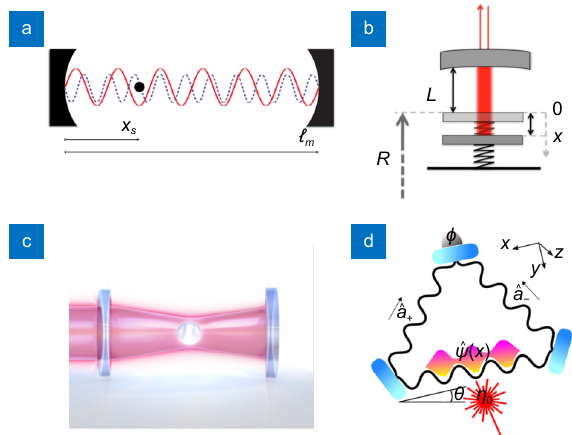
Fig. 29 | Schematics of different setups for light-matter interac- tion based detection. ( a ) A cavity with a microdisk trapped by a light field, which is cooled for a readout by a second light field 166 . ( b ) An optomechanical cavity with an injected light field and an elastic mechanical mirror 164 . ( c ) An optomechanical system with a trapped and laser-cooled nanodiamond 165 . ( d ) A ring cavity comprising three tilted mirrors 167 . Figure reproduced with permission from: (a) ref. 166 and (b) ref. 164 , America Physical Society; (c) ref. 165 , Springer Nature; (d) ref. 167 , John Wiley and Sons.